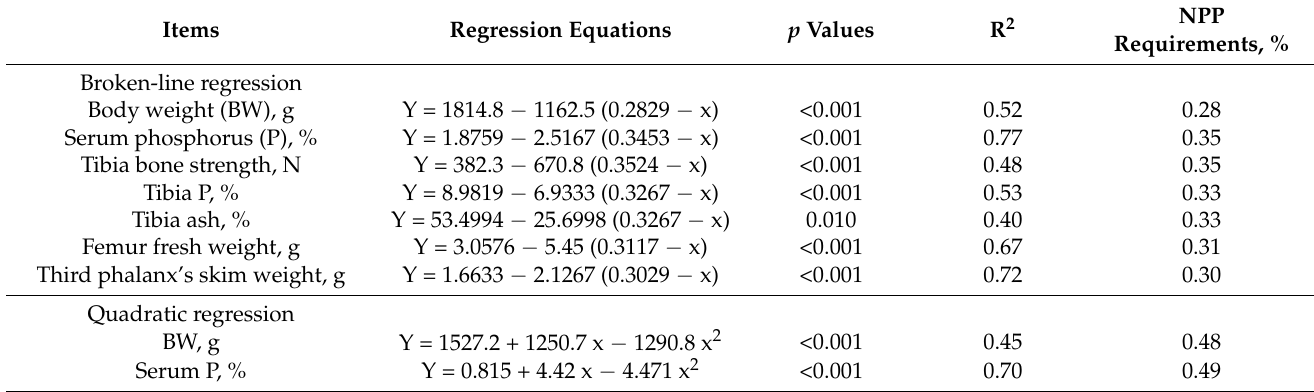
Table 6. Dietary non-phytate phosphorus (NPP) requirement for 1- to 28-day-old goslings based on two regression